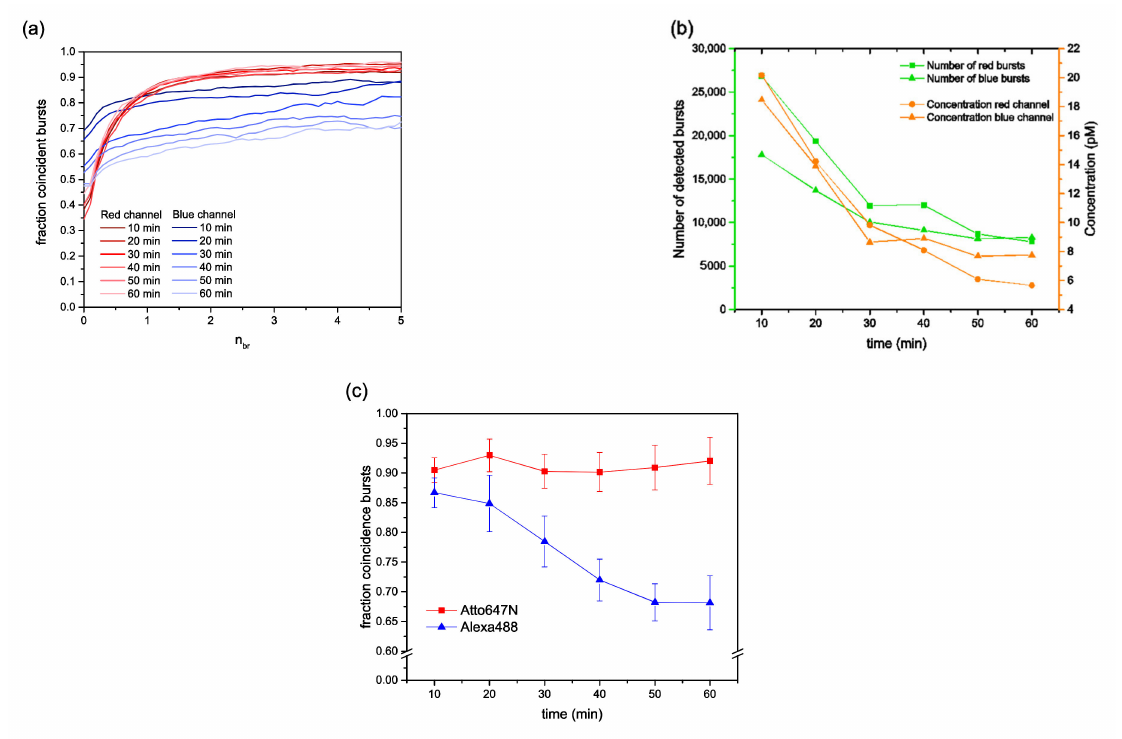
Figure 1. BTCCD results of double-labelled dsDNA samples as obtained from measurements at standard buffer conditions (only PEGylated surfaces, see Sections 2.1 and 2.6). ( a ) Coincidence fractions, f RB (blue) and f BR (red), are shown as a function of the brightness-gating parameter n br for consecutive 10 min time intervals after the measurements were started. ( b ) On the basis of the data shown in ( a ), the time course of the dye concentration in solution was provided in terms of “total number of bursts” as obtained in the respective time interval (see the left y-axis) and in the molar concentration (see the right y-axis). ( c ) On the basis of the data shown in ( a ), the time course of the individual coincidence fractions f RB (blue) and f BR (red) are shown.